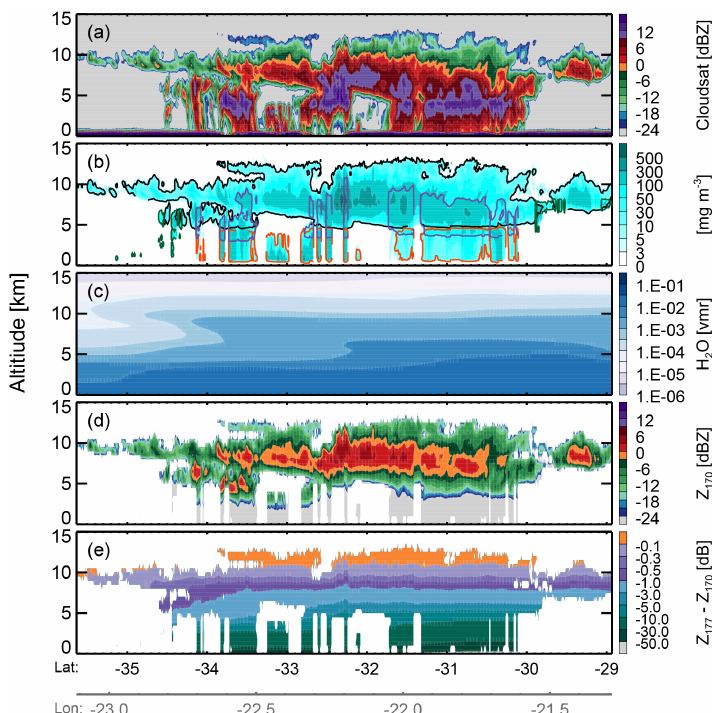
Figure 2. Cross section exemplifying the CloudSat-driven simulations (data from 15 January 2007 over the South Atlantic Ocean). (a) Cloud- Sat radar reflectivity. (b) CloudSat retrieved total (IWC+LWC+rain+snow) hydrometeor water content. Black, green, red and purple lines, respectively, delimit areas where IWC, LWC, rain, and snow were present. (c) ECMWF-aux water vapor. (d) Simulated CloudSat-driven radar reflectivity at 170GHz. (d) Simulated radar reflectivity difference